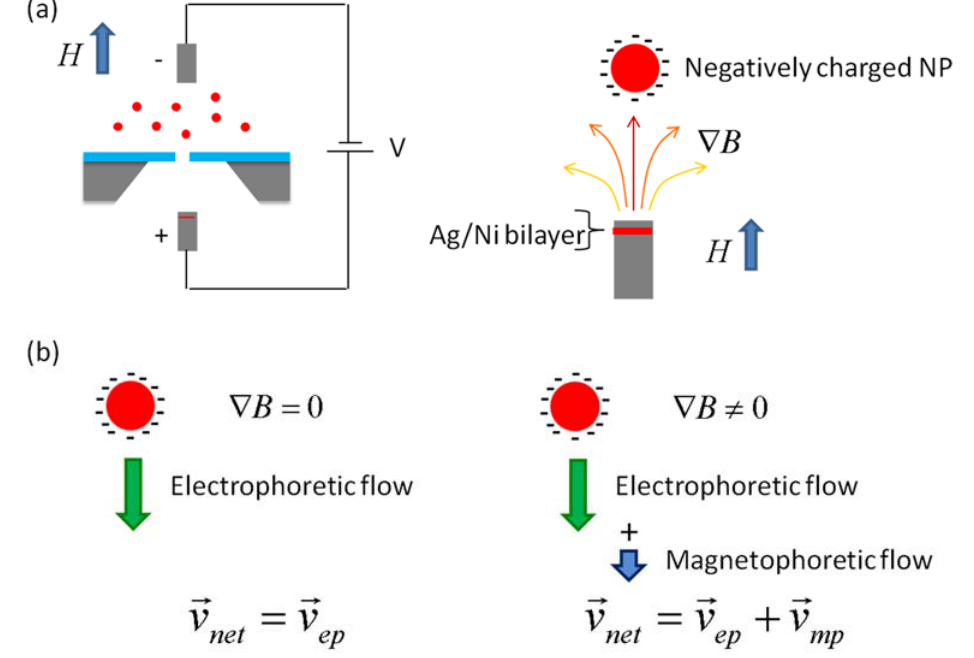
Figure 1. Schematic of the nanopore device that a single magnetic nanoparticle passes through; ( a ) a charged magnetic NP in solution moves through the nanopore under both an electric field (electrophoresis) and a magnetic field gradient